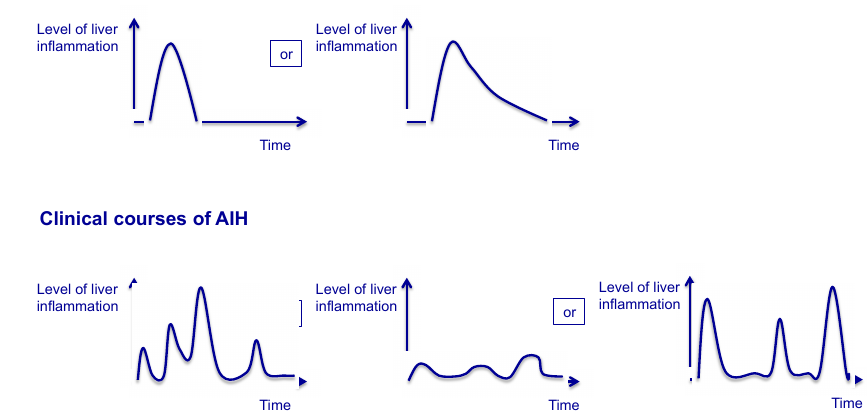
Figure 1. Different clinical courses of herbal and dietary supplements (DILI/HDS) and Autoimmune hepatitis (AIH).